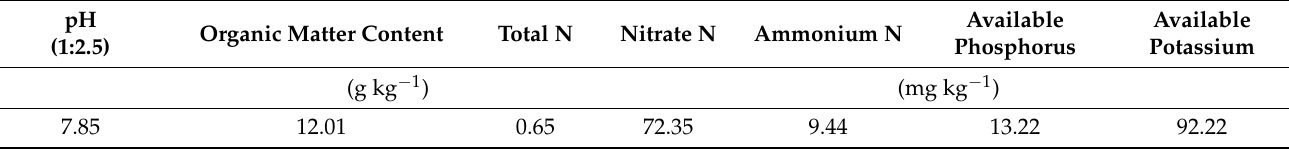
Table 1. The fundamental properties of soil in this experimental